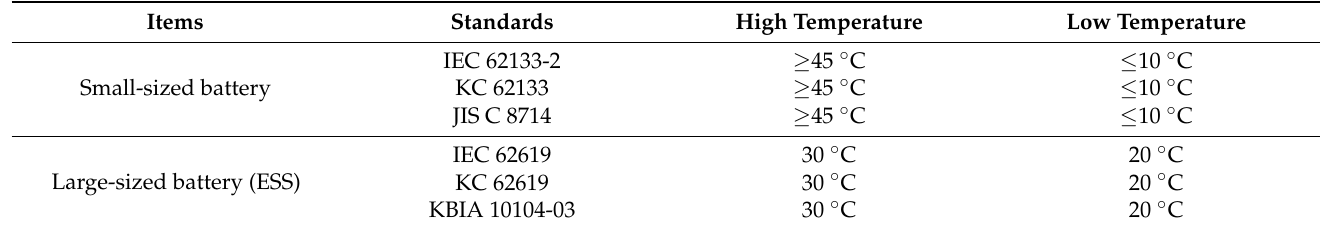
Table 2. Temperature of charge preprocessing in standards applied to small- and large-sized batteries.